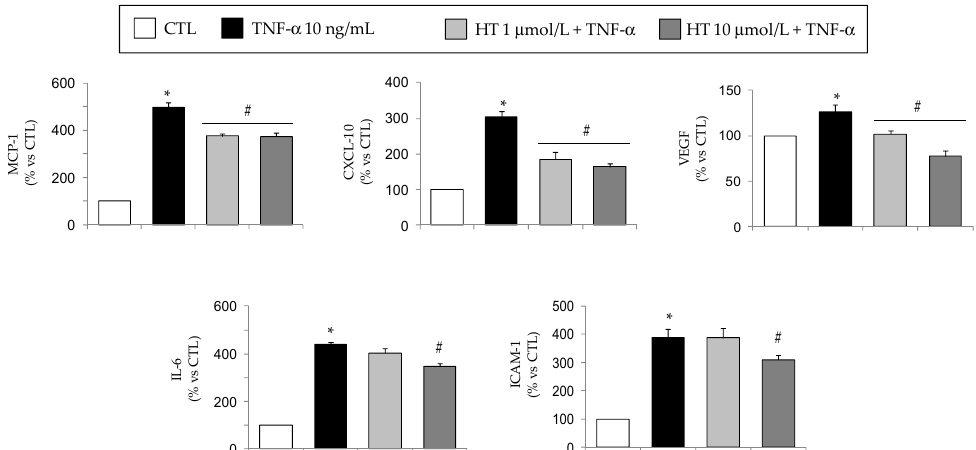
Figure 6. Attenuation by HT of TNF- α -induced protein release of adipokines in human adipocytes. SGBS adipocytes were pretreated with HT (1 h) at the concentrations indicated, and then treated with 10 ng / mL TNF- α for 18 h. Adipokine levels in the culture medium and ICAM-1 surface expression were determined by ELISA, and expressed as percent of untreated control (CTL). Bars represent means ± SD ( n = 3). * p < 0.05 vs CTL. # p < 0.05 vs TNF- α alone. At Western analysis, TNF- α caused a significant induction of COX-2 protein expression and a corresponding release of the COX-2 inflammatory product PGE 2 in the culture medium, that were completely prevented by HT (Figure 7A and 7B). Concordantly, HT also restored the reduced protein expression of eNOS as induced by TNF- α (Figure 7C).